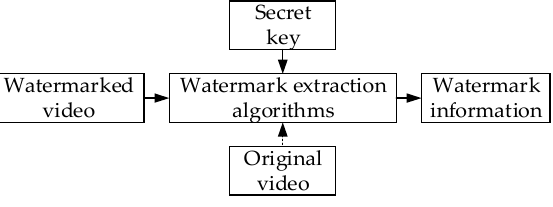
Figure 6. The basic model of watermark extraction.